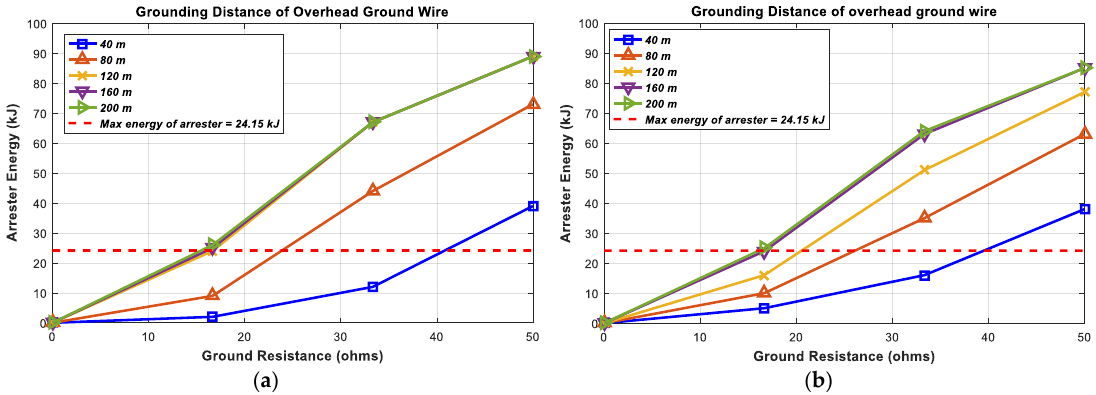
Figure 20. Arrester energy discharge in the case of a lightning strike to the overhead ground wire